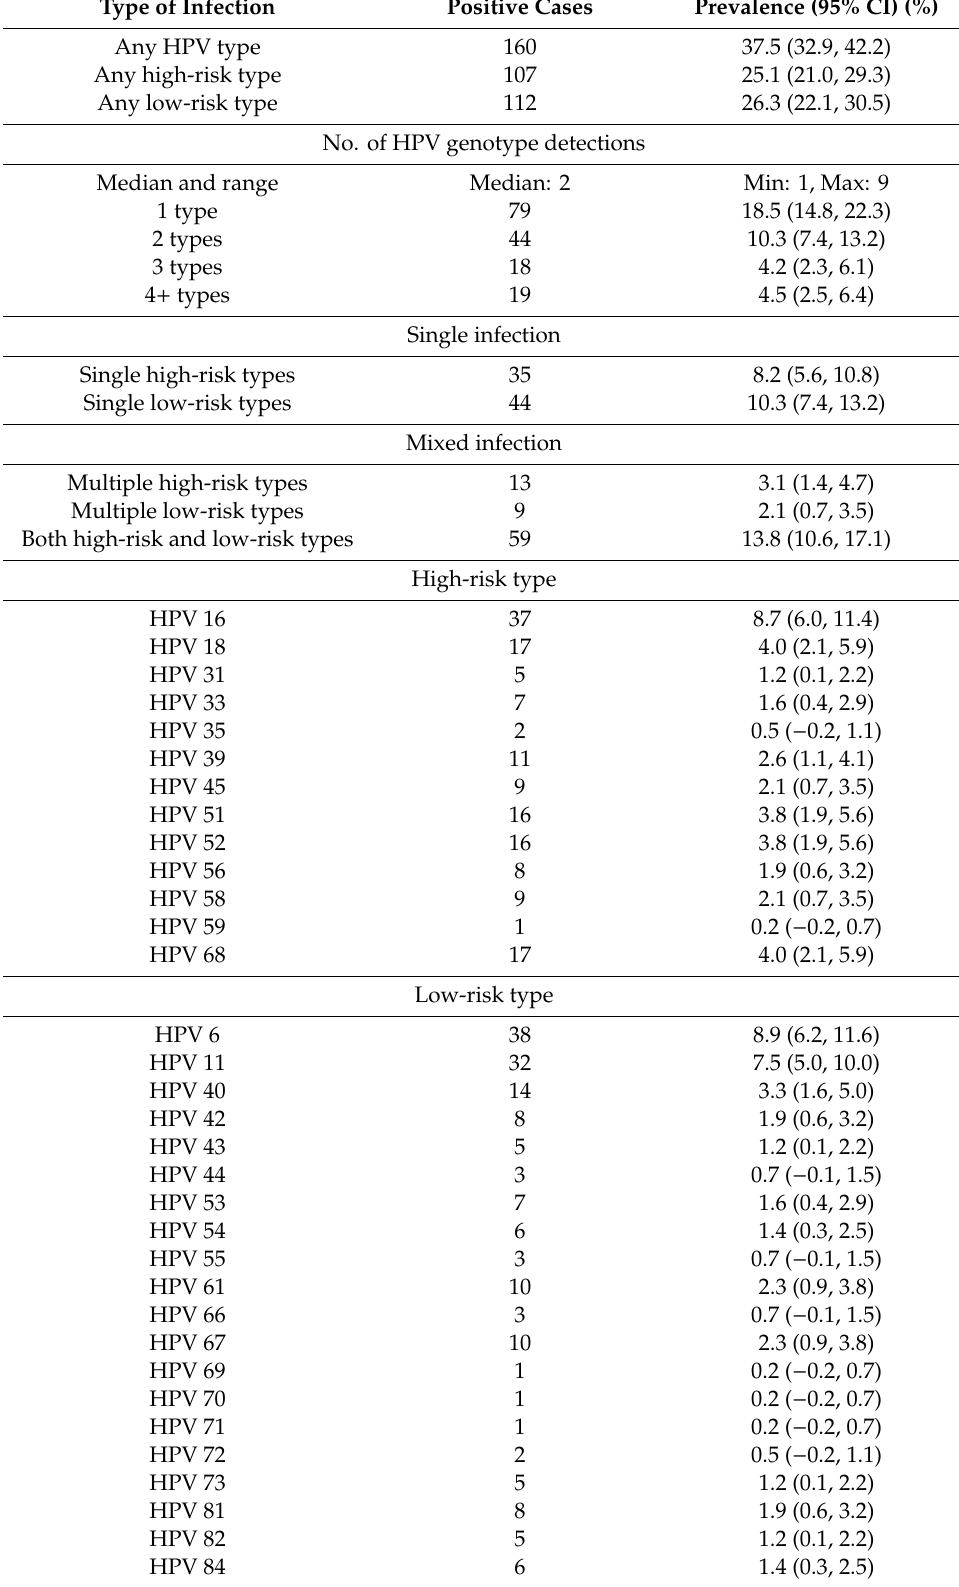
Table 2. Type-specific anal HPV detection among MSM attending university in China ( n =